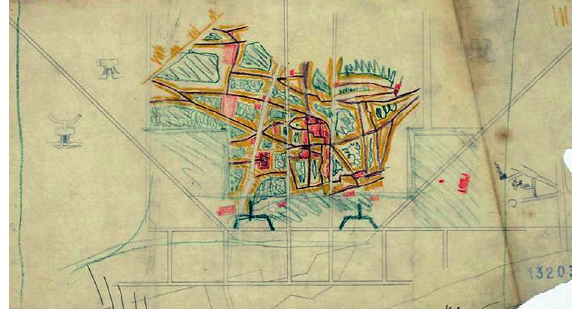
fig. 9. Study to transform the old city centre of Barcelona (flC 13203)